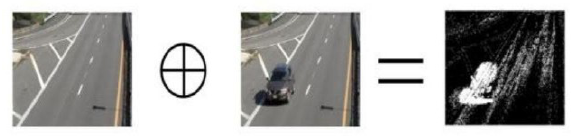
Fig. 11: Background Image Subtraction using XOR